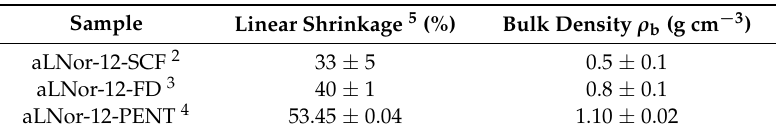
Table 3. Comparison of gels with different drying methods 1